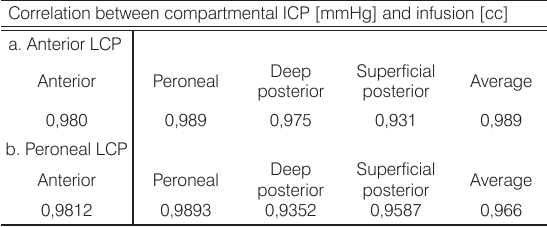
Table 1. Pearson’s correlation coefficient.